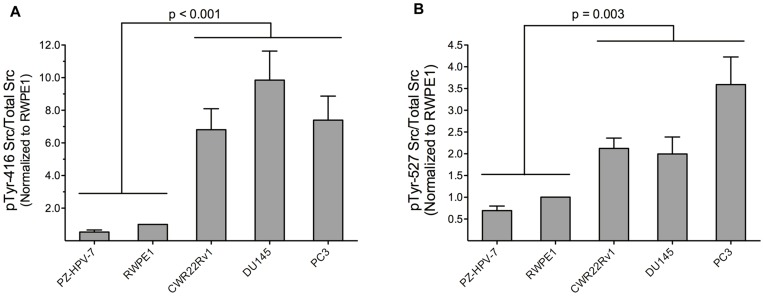
Src phosphorylation status in non-invasive (PZ-HVP-7, RWPE1), androgen-independent (CWR22Rv1), and invasive (DU145, PC3) cell lines.(a) pY416 levels were derived from the band intensities in the western blots (Fig. 3A), normalized to the corresponding α-tubulin control, and then compared to cell line RWPE1 (RWPE1 as 1). (b) pY527 levels were derived from the band intensities in the western blots (Fig. 3A), normalized to the corresponding α-tubulin control, and then compared to cell line RWPE1 (RWPE1 as 1). Data are representative of at least three independent experiments and are shown as mean with SEM. p values are indicated.